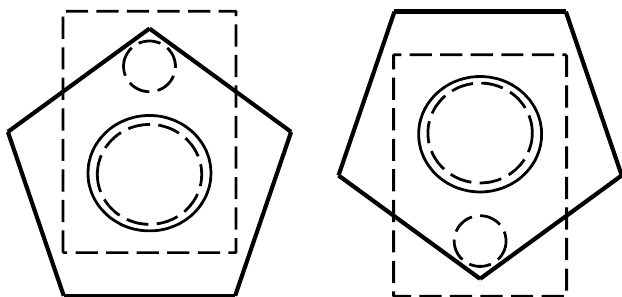
Figure 3. Placement of the face of the directional loudspeaker according to the placement of the face of the dodecahedron speaker (twelve positions measurements).